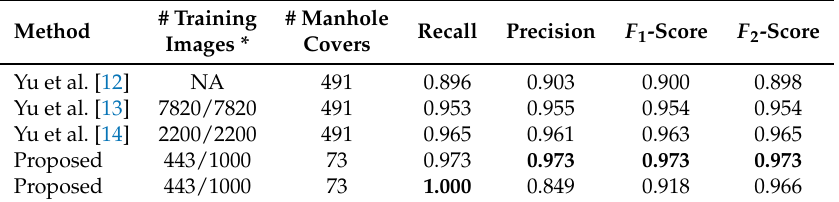
Table 8. Summary of the detection results of different manhole cover detection approaches on intensity ground